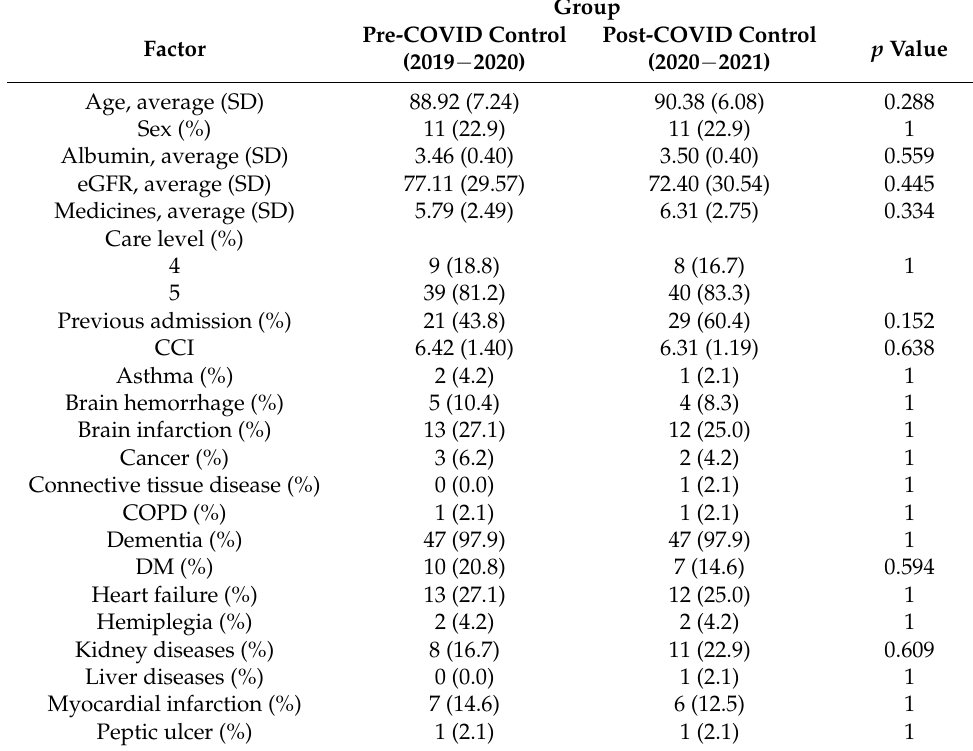
Table 1. Demographic data of the patients.